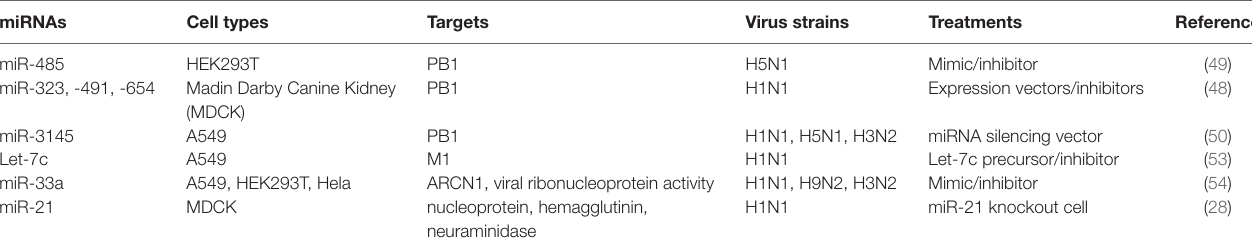
TAble 2 | MicroRNAs (miRNAs) target viral RNAs.